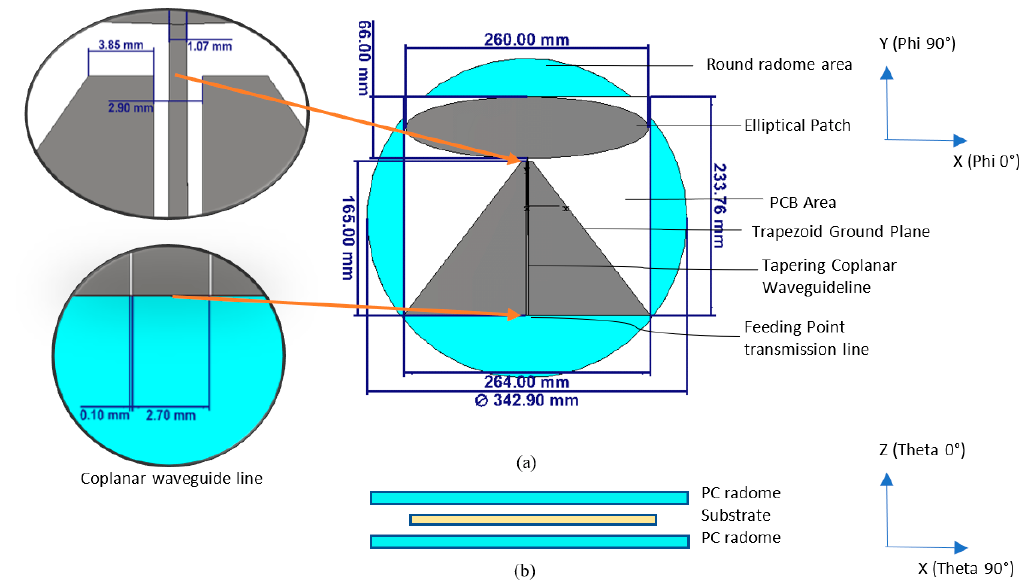
Figure 2. ( a ) Top View and ( b ) Side View of conventional super wideband 2D planar discone (elliptical monopole radiating element with trapezoid ground plane) and tapering coplanar transmission line without adjustment to fit into the small round radome.